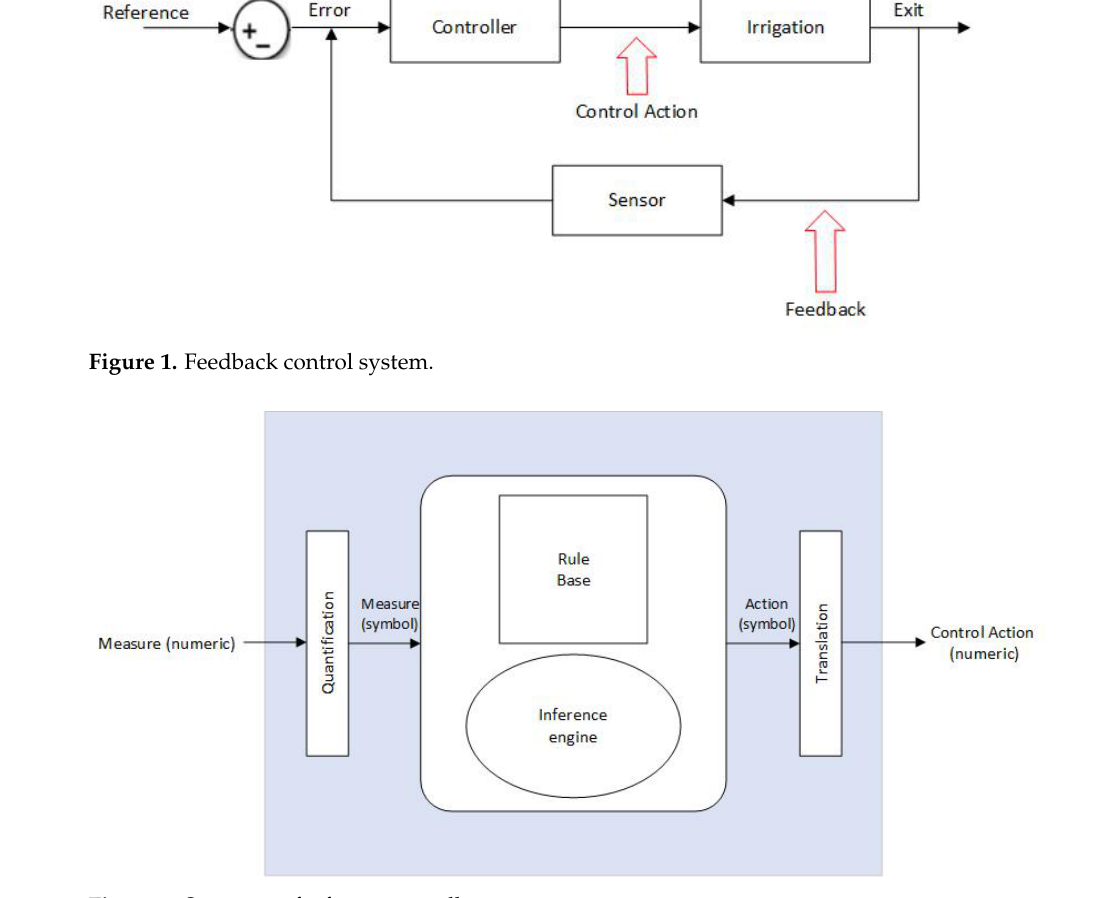
Figure 2. Structure of a fuzzy